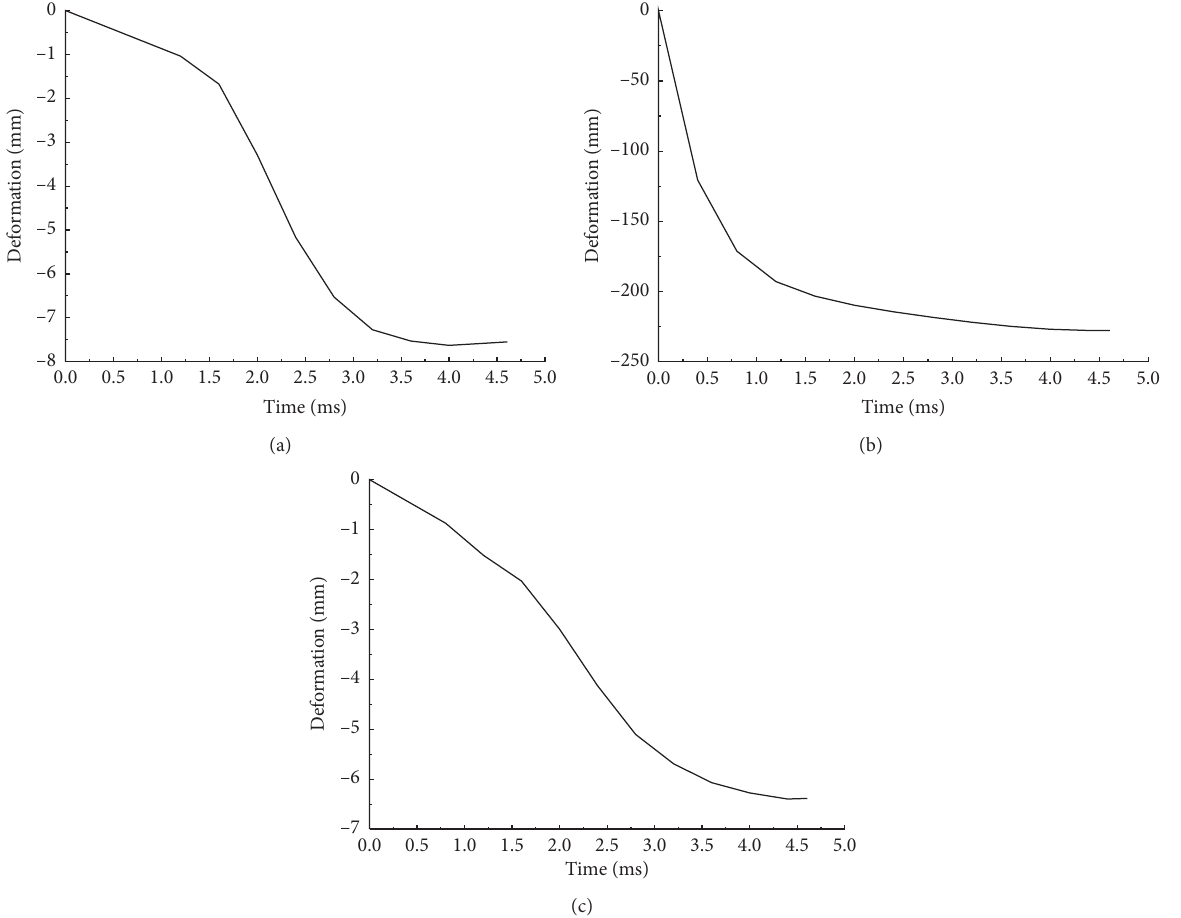
Figure 14: Deformation-time curve at different positions of the column surface facing the explosive. (a) Bottom of column. (b) Middle of column. (c) Top of column (CFDST